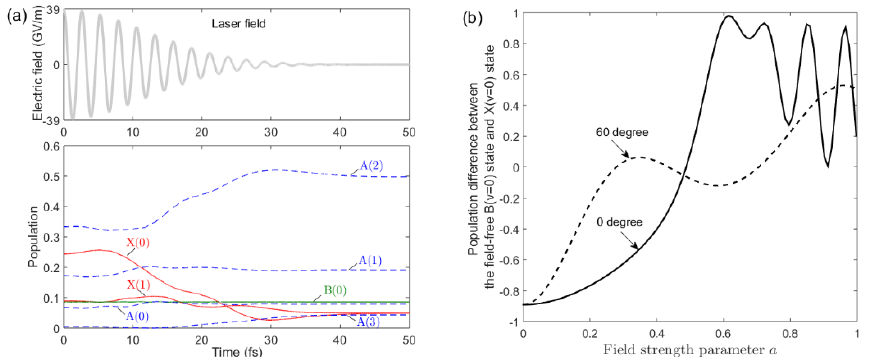
Fig. 1. (a) Time-dependent population on the Floquet states at the field intensity of 2 × 10 14 Wcm −2 , and N 2+ ions are aligned so that the angle between the N-N molecular axis and the polarization direction of the laser field is 𝜃 = 60° . (b) Final population difference between the field-free B( v = 0) state and X( v = 0) state, Δ𝑃 = 𝑃(𝐵) − 𝑃(𝑋) , as a function of the laser field strengths obtained as the exact solutions of the Schrödinger